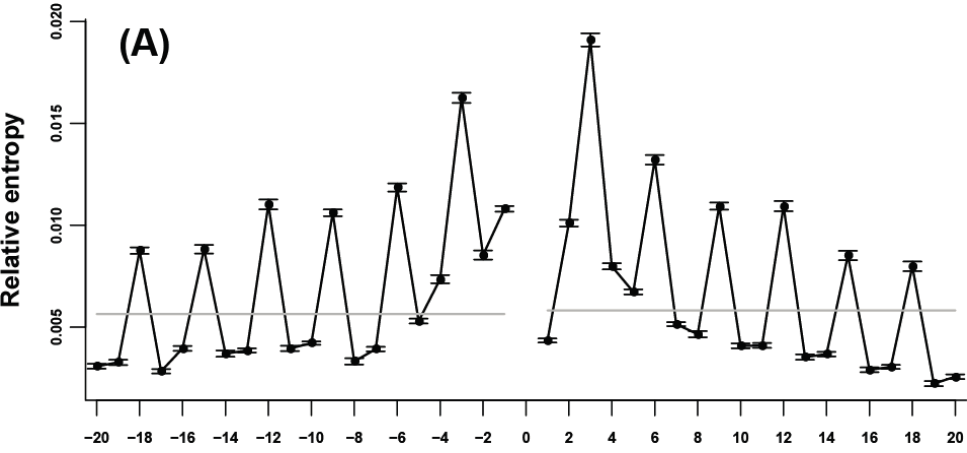
Figure 3. Neighbor preference pattern of the amino acid G. ( A ) Relative entropies of the neighboring sites of G of N - and C -termini; ( B ) Boxplot of the 20 relative entropies at each flanking site of the amino acid